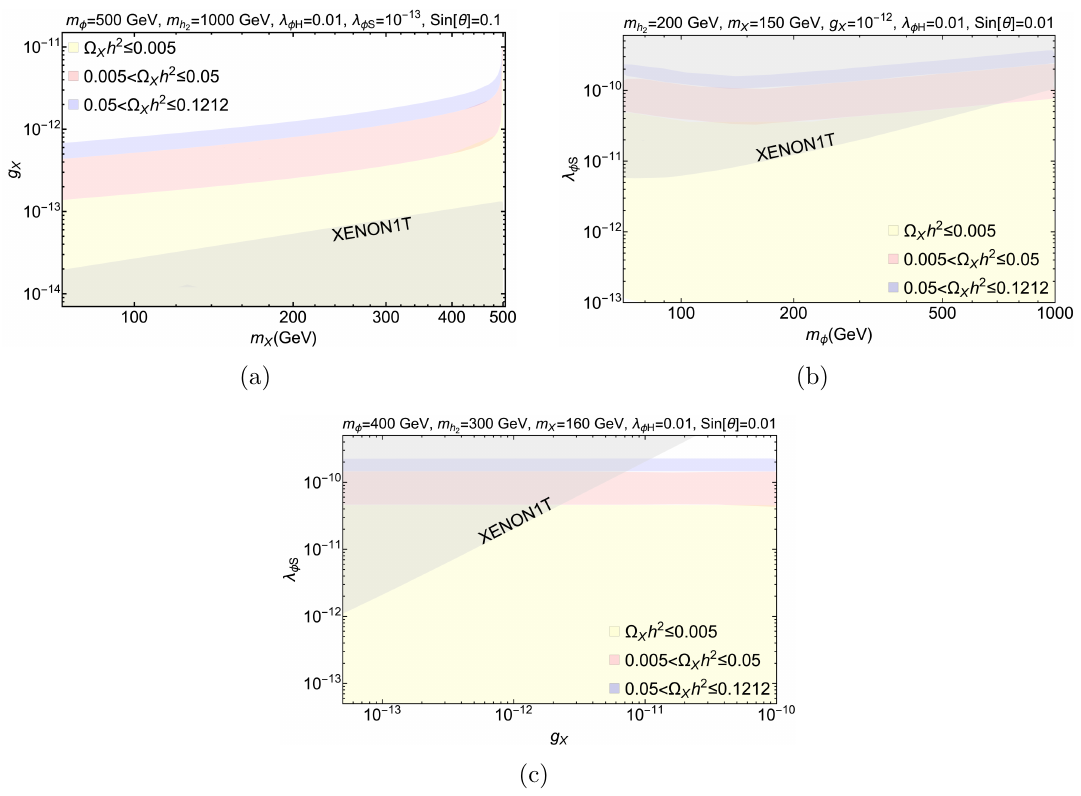
Figure 19 . Under abundant ( Ω X h 2 ≤ Ω T h 2 ) parameter space for DM freeze-in aEWSB. Fig- ure 19(a) shows a correlation in g X vs. m X plane with direct search constraint restricting the smaller g X values shown by the grey shaded region. In figure 19(b), the under abundant region in λ φS vs. m φ plane is shown, with grey shaded region ruled out by the XENON1T direct search bound. The relic density of FIMP DM is indicated by color code in the figure inset. In figure 19(c), we show the viable parameter space in λ φS vs. g X plane for the scattering dominated production of FIMP. Direct search limits weaken for smaller λ φS and larger g X . Parameters kept fixed are mentioned in figure